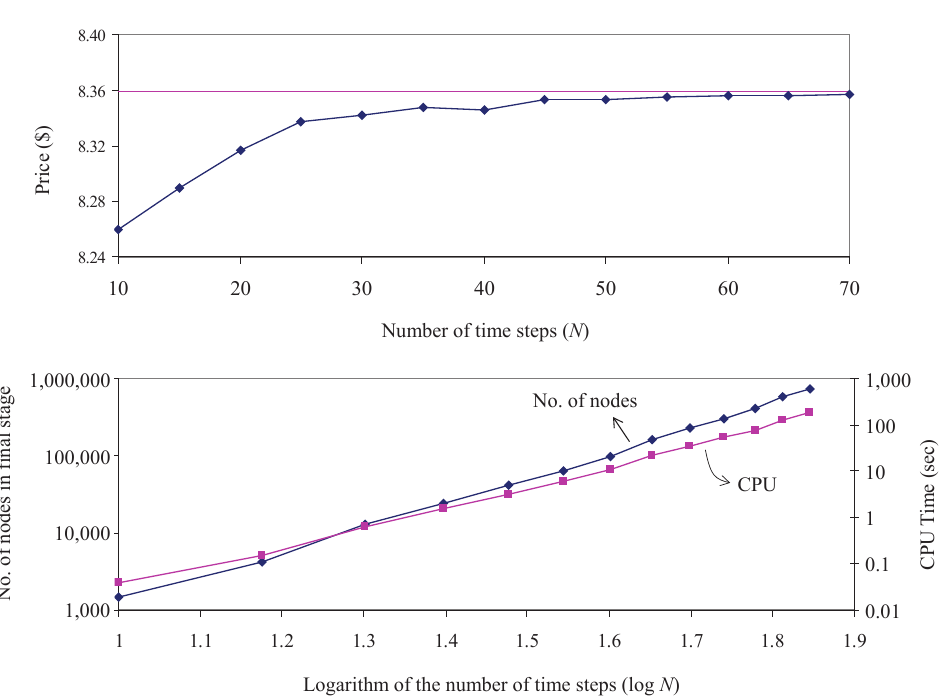
Figure 4. Convergence pattern of the option prices and the computational